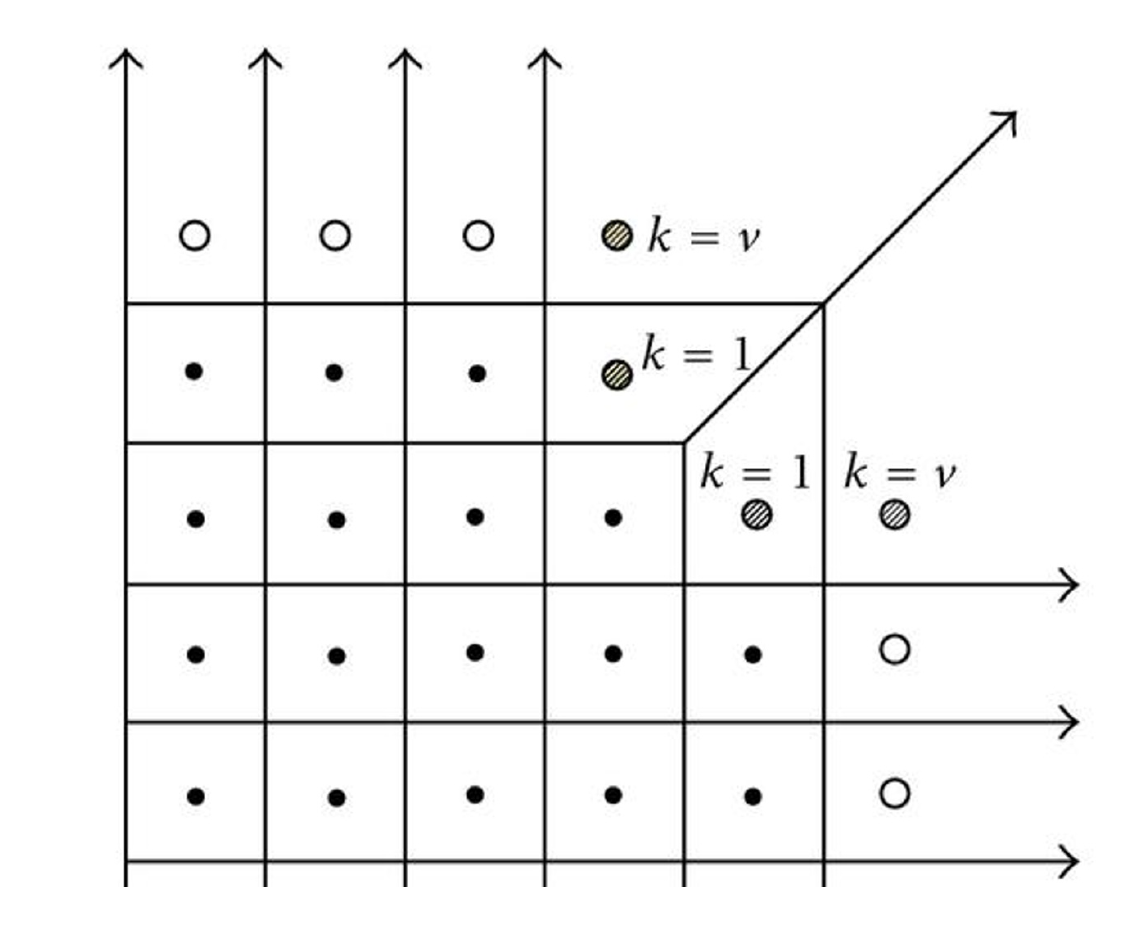
Figure 2 Decision boundaries for symbols in cross-QAM. The black points, hollow points, and slash points represent the interior symbols, edge symbols, and corner symbols, respectively. In particular, only one quadrant of the cross 128-QAM constellation ( ) is shown here as an